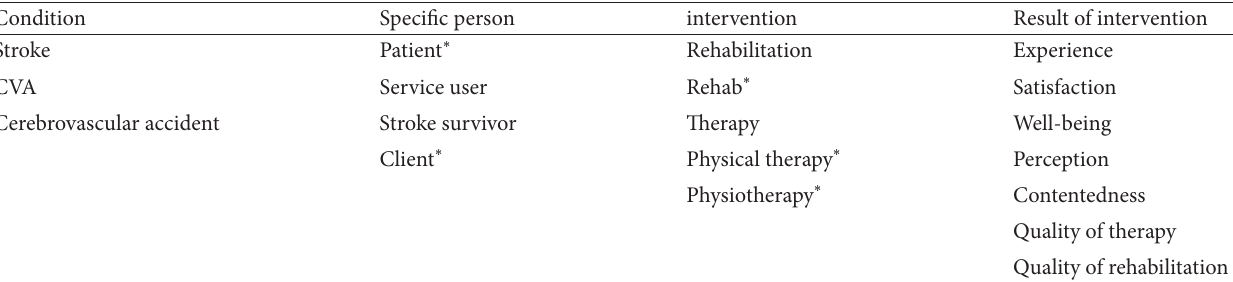
Table 1: The database search